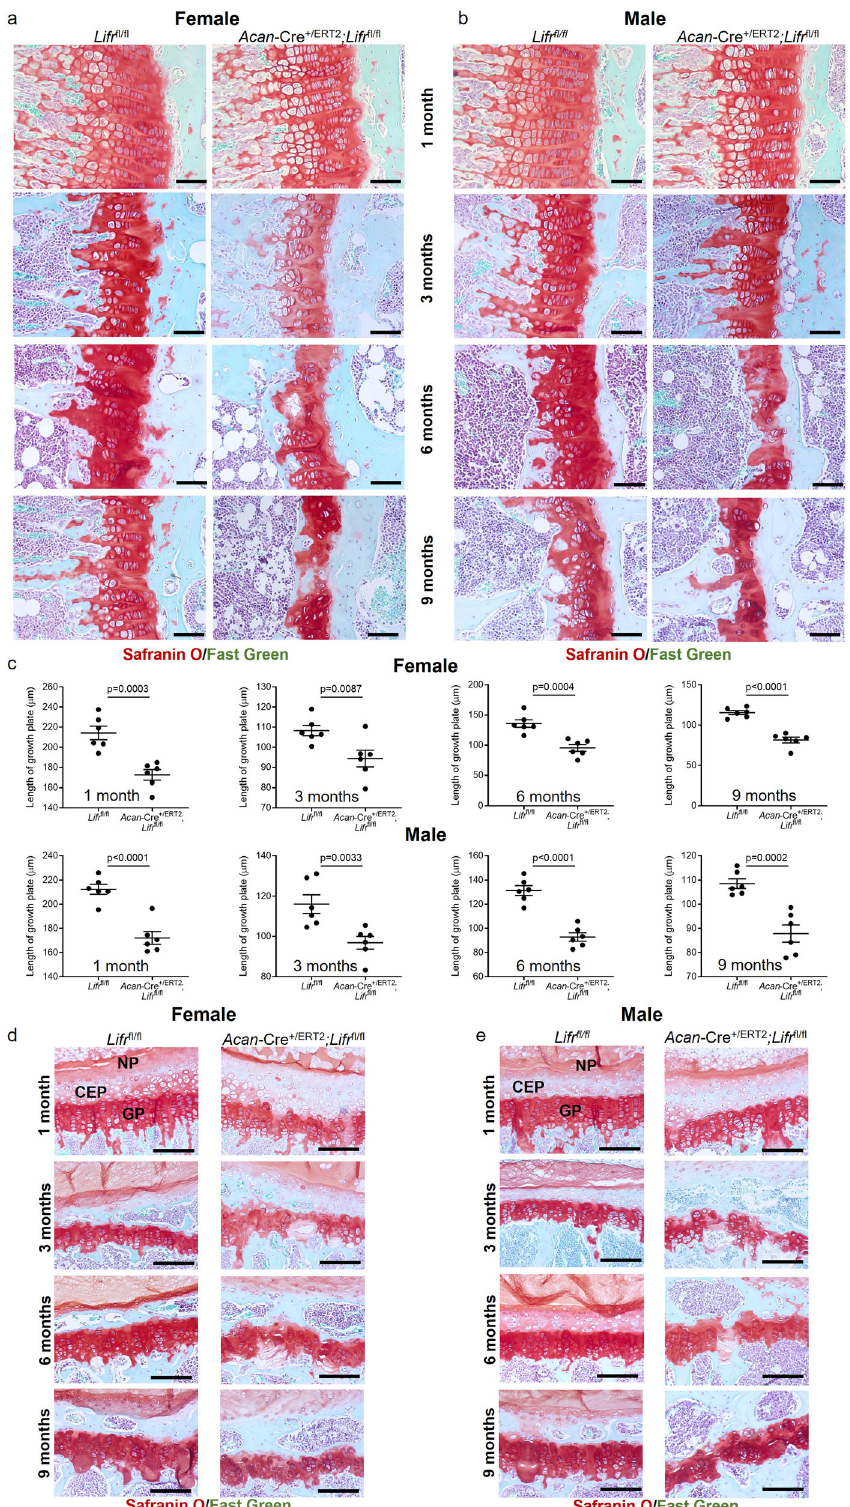
Fig. 8 Postnatal loss of Lifr in chondrocytes partially phenocopies Stat3 deletion. Proximal tibial growth plates were signi fi cantly reduced in thickness at all ages examined following deletion of Lifr at P2/P3 in female ( a , c ) and male ( b , c ) mice; growth plate disruptions were not as severe as those observed in Stat3 and gp130 deletion mutants. Vertebral growth plates were mildly reduced in thickness, coupled with occasional disruption of integrity at later ages examined, in both female ( d ) and male ( e ) Acan -Cre + /ERT2 ; Lifr fl / fl mice as compared to Lifr fl / fl controls. AF annulus fi brosis, CEP cartilaginous endplate, NP nucleus pulposus. In all panels, scale bars = 50 µ m; n =